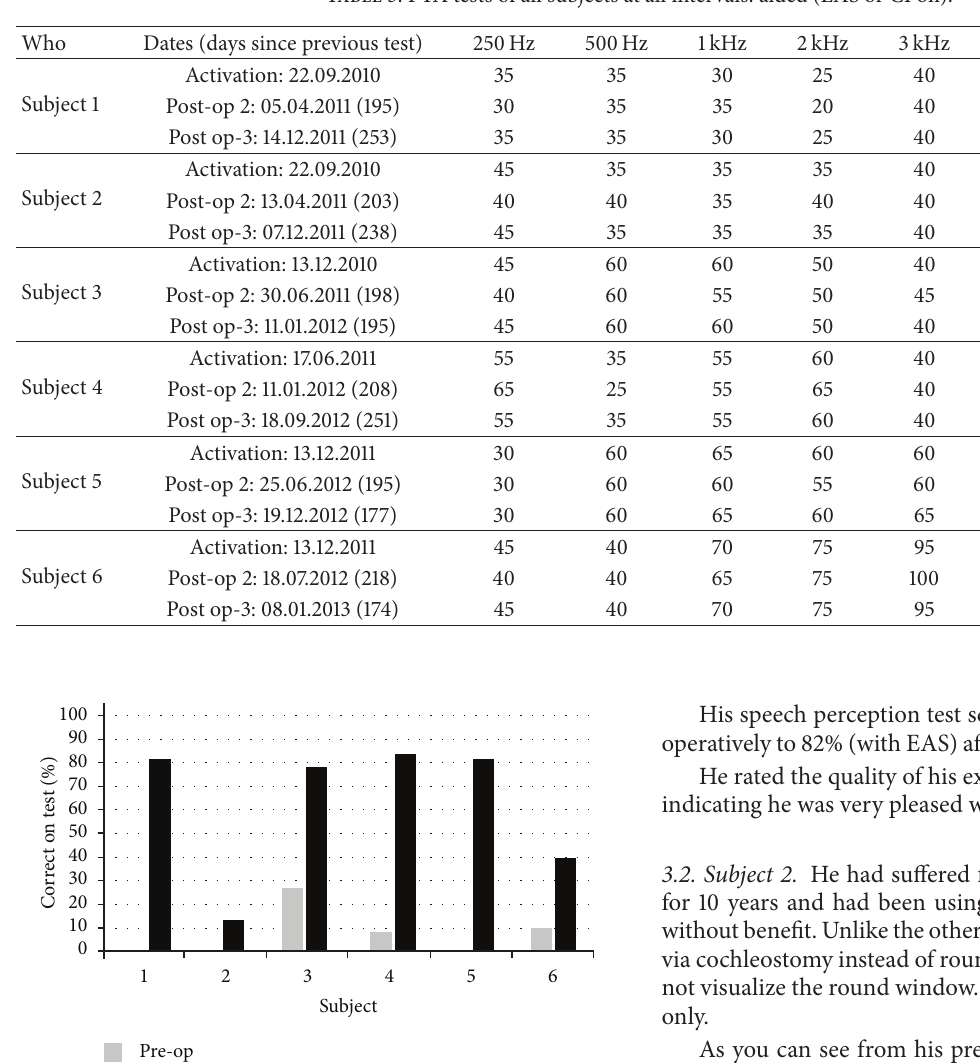
Table 3: PTA tests of all subjects at all intervals: aided (EAS or CI on).